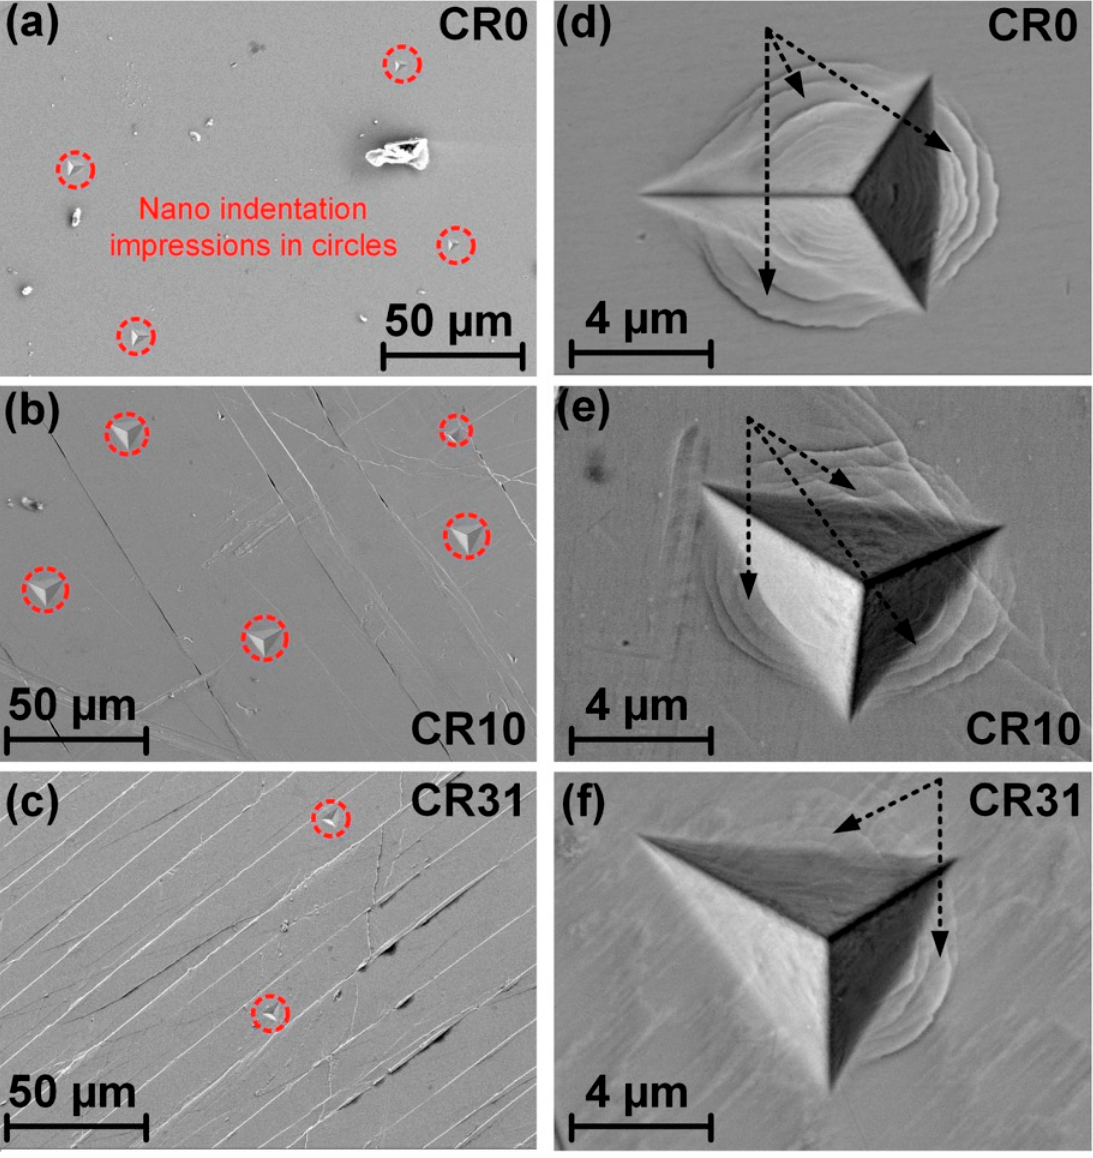
Figure 8. SEM secondary electron (SE) images showing nanoindentation marks in ( a ) CR0 along with evolved shear bands on the NR plane upon cold rolling in ( b ) CR10 and ( c ) CR31. The magnified image of indentation impression at P max = 500 mN showing shear bands in ( d ) CR0, ( e ) CR10, and ( f ) CR31.